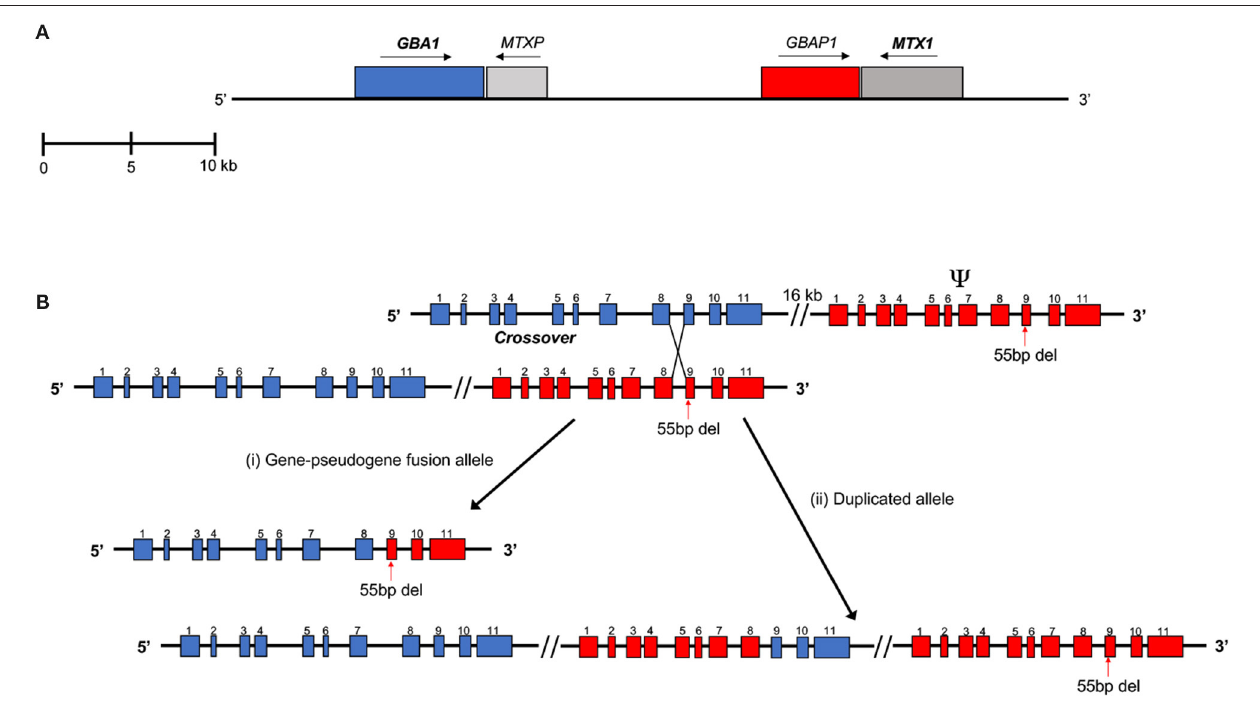
FIGURE 1 | (A) Scaled representation of GBA1 , MTX1 , and their highly homologous pseudogenes. MTXP lies in the 16kb region between GBA1 and GBAP1 . MTX1 and MTXP are transcribed in the direction opposite to that of GBA1 and GBAP1 . (B) Example of a reciprocal crossover event, resulting in a (i) gene-pseudogene fusion allele and a (ii) duplicated allele. These recombinant alleles are difficult to detect using next-generation sequencing methods. Sequence reads containing the pseudogene-derived segment (red) of the recombinant alleles may align to the pseudogene instead. This can lead to false negatives and reduce the read depth of GBA1 . In this example, reads containing the 55 bp deletion from the recombinant alleles may align preferentially to the pseudogene (Adapted in part from Tayebi et al., 2003